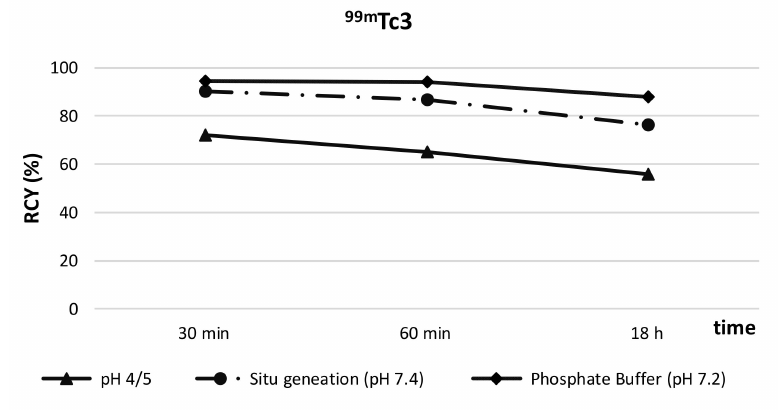
Figure 2. Over time variation in RCY(%) of 99m Tc3 as function of the pH.